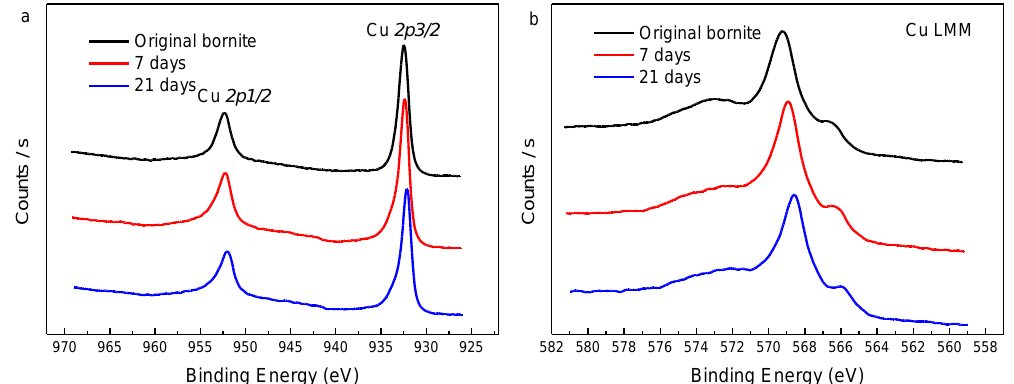
Figure 9. Cu 2p XPS spectra ( a ) and Cu LMM XPS spectra ( b ) of bornite residues after bioleaching for 7 days and 21 days.